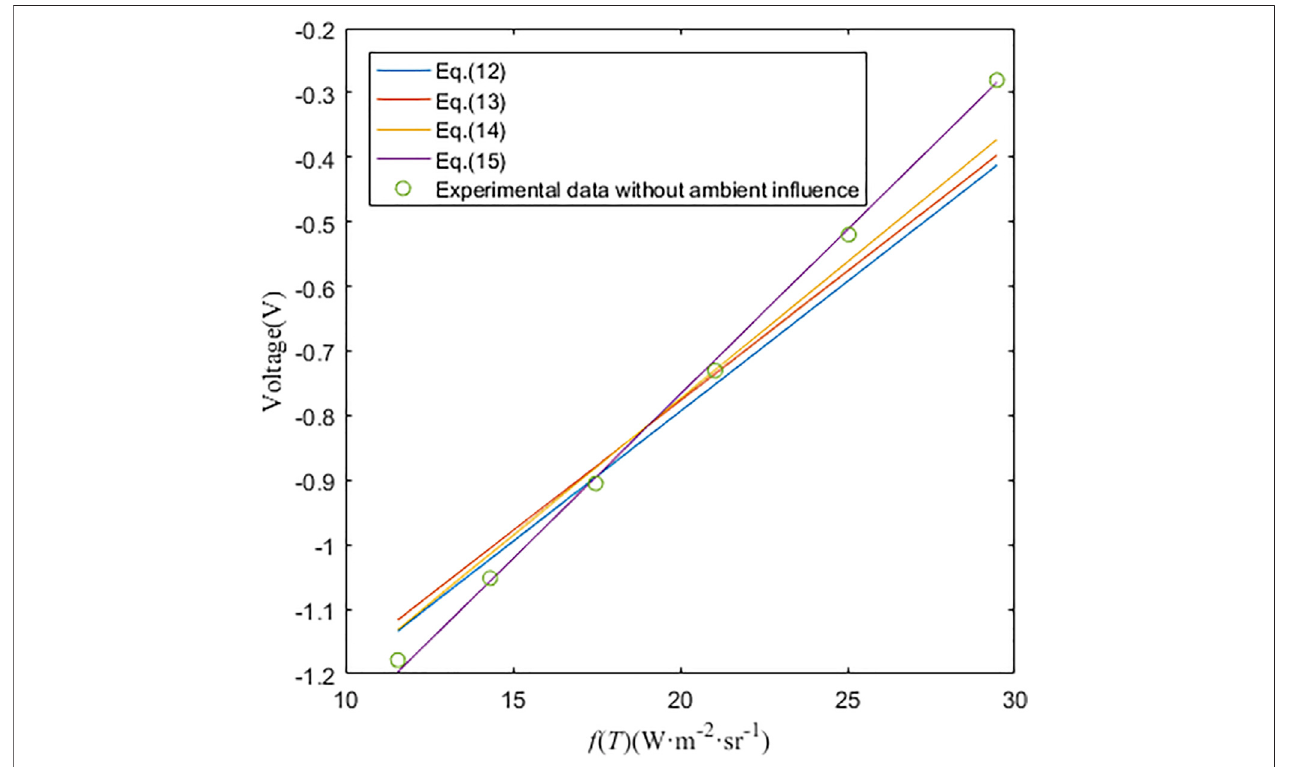
FIGURE 3 | Calibration functions and experimental data without environmental